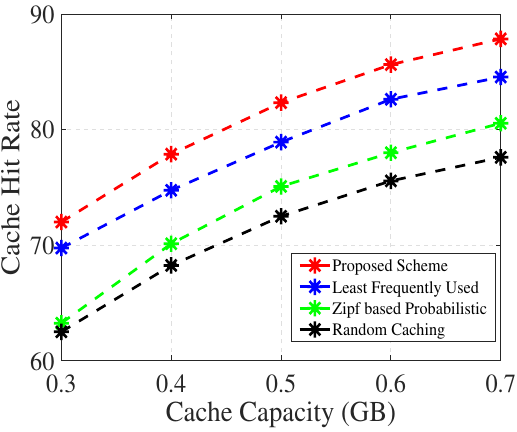
Figure 7. Cache hit rate versus cache capacity with F = 100, H = 50